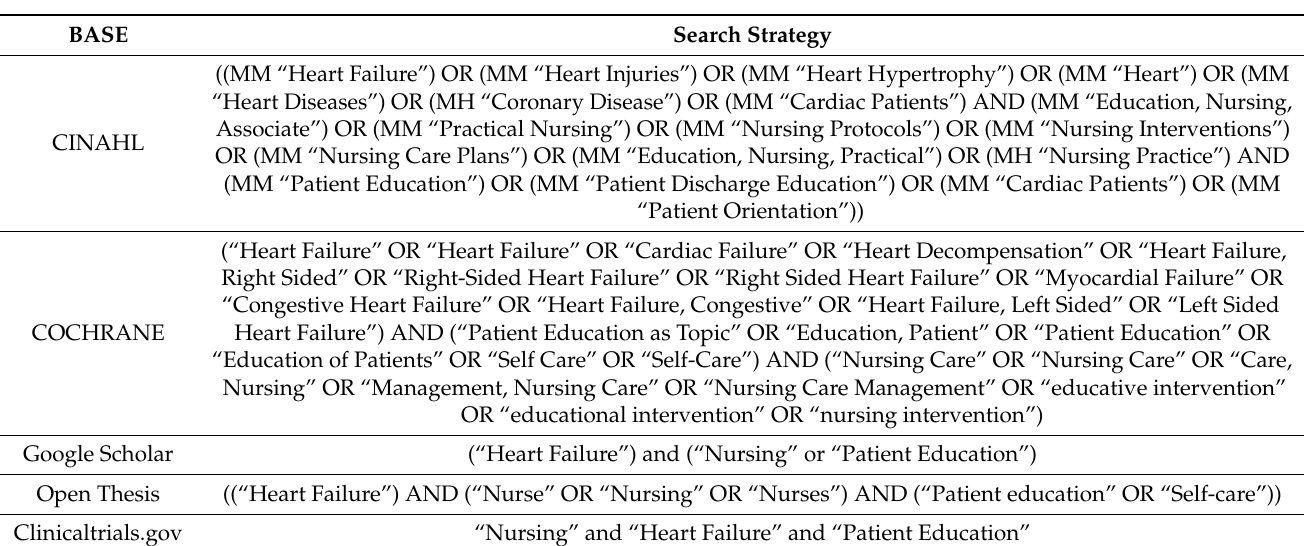
Table A2. Risk of bias assessment.